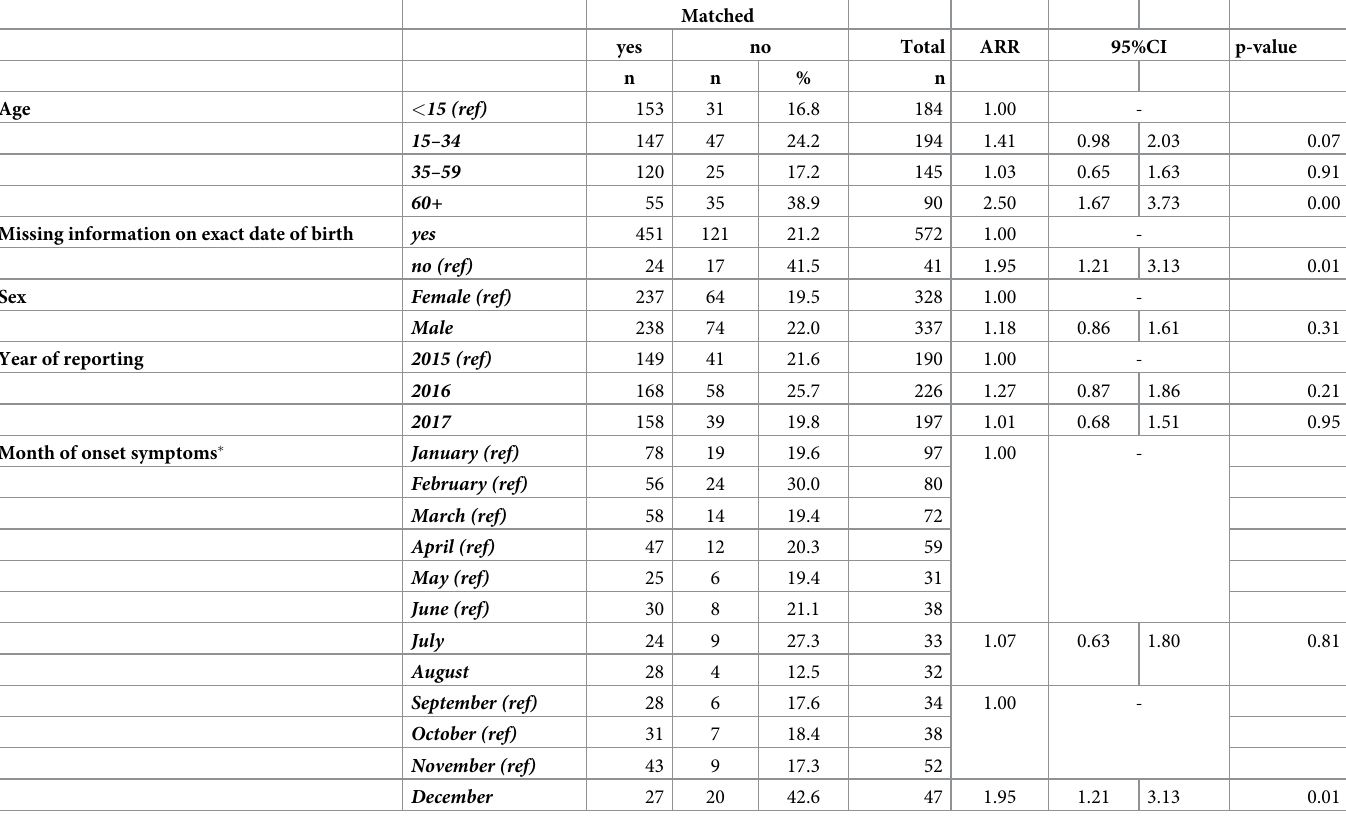
Table 4. Characteristics of reported Invasive Meningococcal Diseases (IMD) cases at the Italian enhanced surveillance system and Adjusted Risk Ratios (ARR) of being unmatched with IMD hospitalizations, Italy